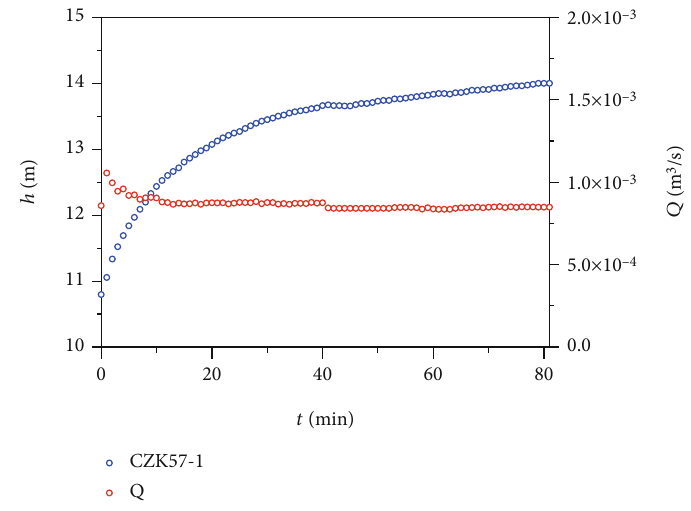
Figure 5: Flow rate of injection borehole and water level of observation borehole